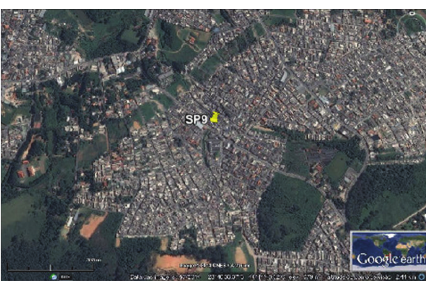
Figure 8: Image of station SP9 (source: Google Earth, 04 Jul 2014, 08 Dec